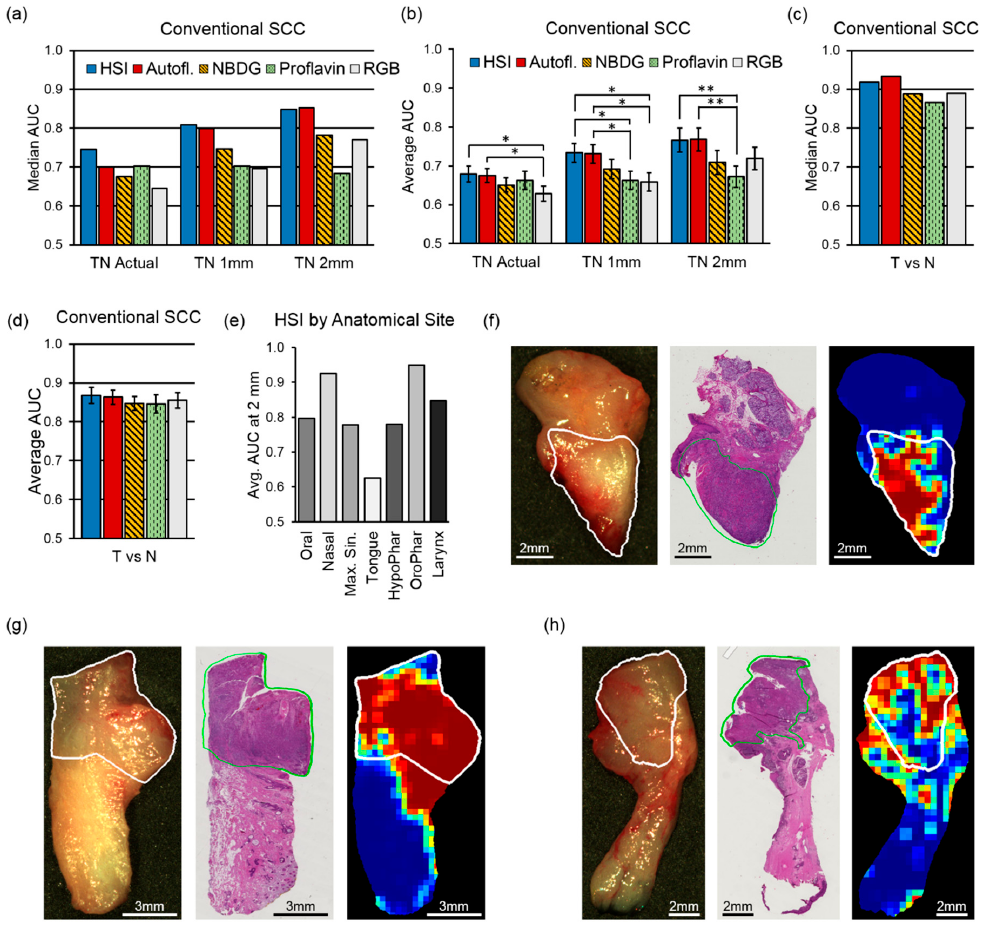
at 2mm from the SCC margin using HSI across di ff erent anatomical sites; ( f–h ) representative patient examples of conventional SCC at the maxillary gingiva, nasal cavity, and larynx, respectively. From left to right: RGB made from HSI, histology ground truth, and predicted cancer heat-map. The white and green contours outline the SCC